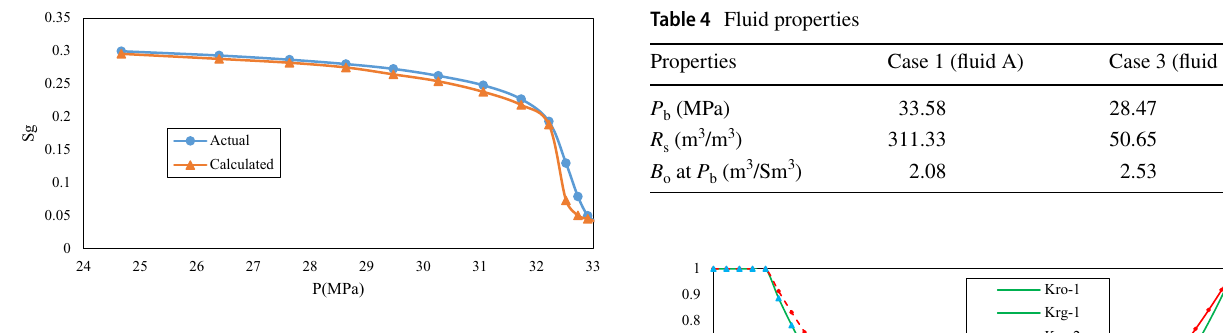
Fig. 10 Actual (model) and estimated saturation profile near the well- bore at the end of DD test (case 1)